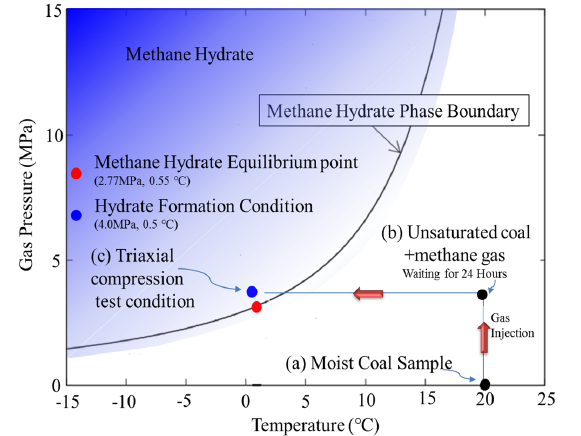
Figure 5. Paths for experimental procedures (modified from [32]).